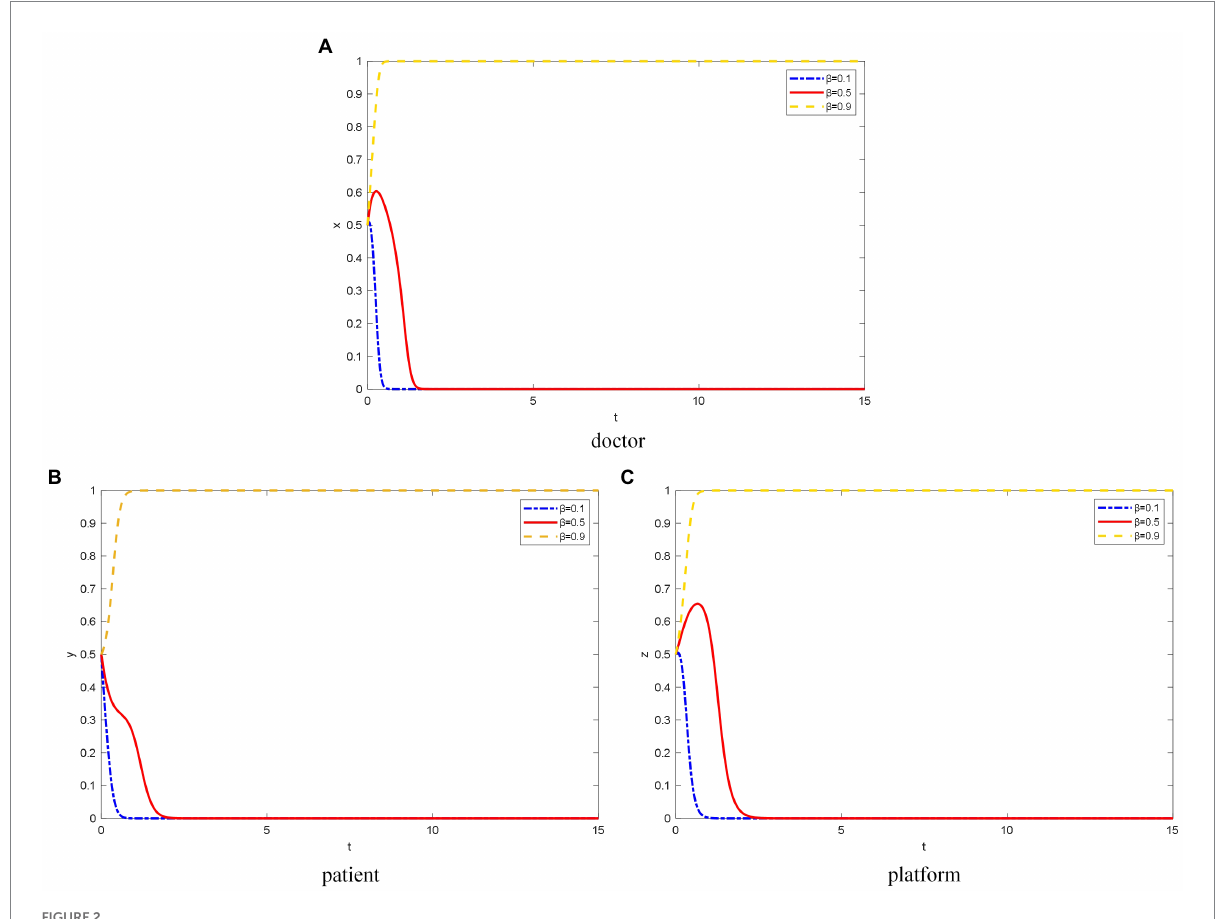
FIGURE 2 The evolution path of different objects’ strategy under different IPISC. (A) Doctor, (B) patient, (C)